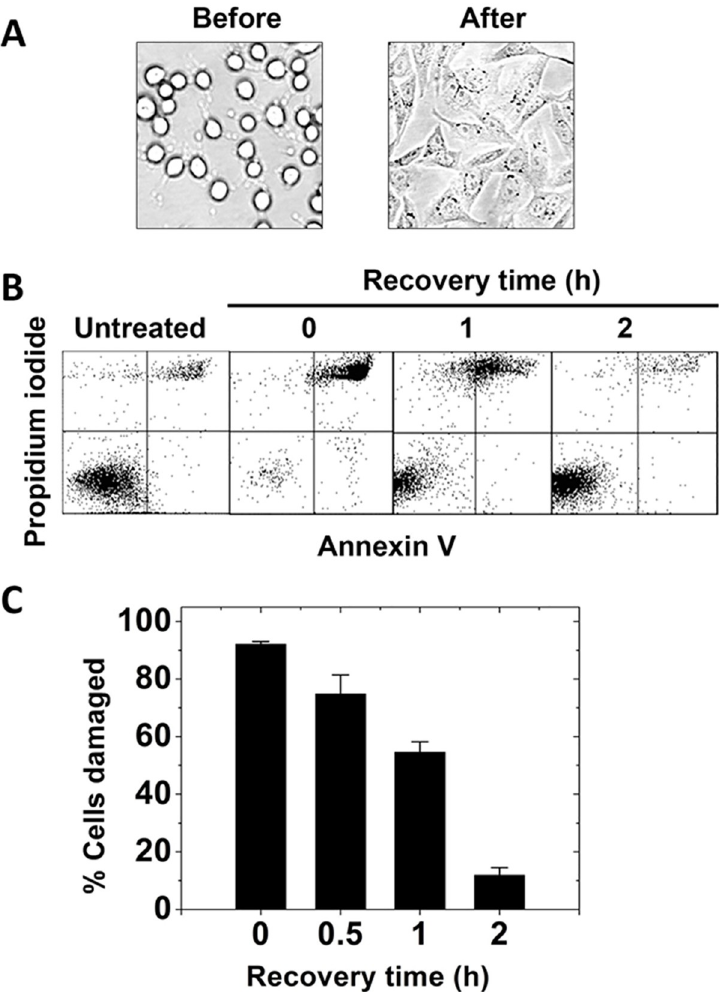
Fig 5. Recovery in complete growth medium reverses/prevents cell damage. A. Bright-field image after 5 mM bSM exchange (before) and after 2h recovery in complete growth medium (after) for CHO cells. B. Examples of dot-plot of flow cytometric analysis of PI and Annexin V staining of CHO cells after exchange with bSM and incubation at different recovery times. (See S5 Fig for raw data with axis values.) C. Fraction of damaged cells (PI positive + PI and annexin V double positive cell) from flow cytometric analysis. Exchange was carried out in 3.5 cm diameter plates at 37˚C with 1 ml of lipid plus 50 mM M α CD. Recovery was carried out at 37˚C in the same plates with 1.5 ml of complete growth medium. Mean and standard deviation from three experiments is